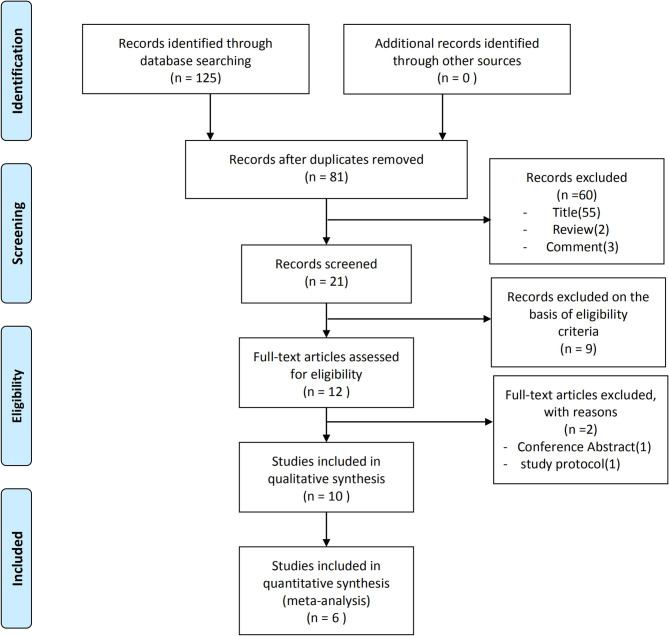
PRISMA flowchart of study selection.